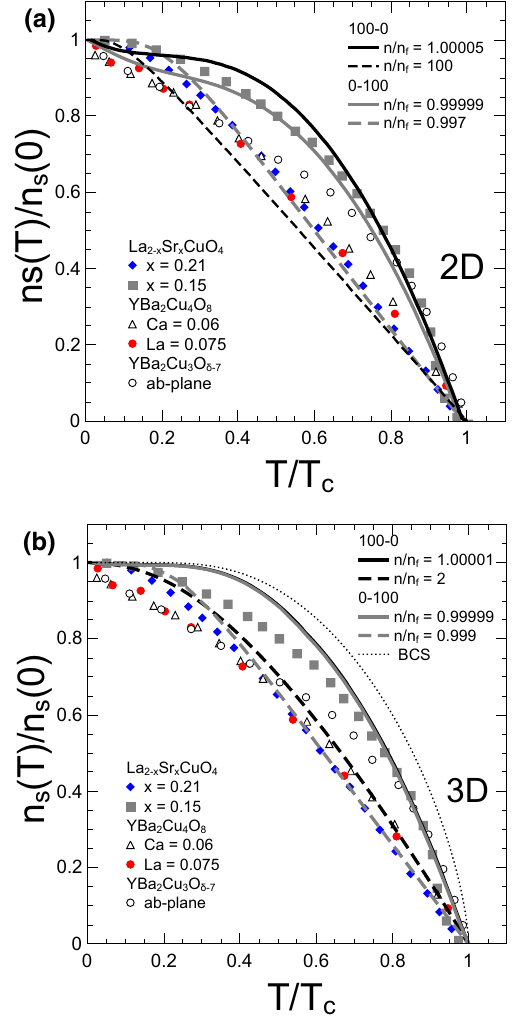
Fig. 3 (Color online) a 2D superfluid density n s ( T )∕ n s ( 0 ) vs T ∕ T c from the extended crossover for 100%–0% case using (17) black- full curve with n ∕ n f = 1.00005 near weak coupling and the black-dashed curve with n ∕ n f = 100 strong-coupling regime. For 0%–100% case using (18) gray-full curve with n ∕ n f = 0.99999 and gray-dashed curve with n ∕ n f = 0.997 each compared with HTSC data of YBa 3 CuO 𝛿 − 7 ab-plane [63] (open circles); La 2 − x Sr x CuO 4 [64] (gray squares) x = 0.15 (blue-online diamonds) x = 0.21 ; YBa 2 Cu 4 O 8 [65], Ca = 0.06 (open triangles) and La = 0.075 (red online circles). There is two important cuprate-SC results shown here between the 100%–0% and 0%–100% cases near the weak cou- pling regime and between the 100%–0% strong-coupling regime and 0%–100% gray-dashed case suggesting that these SCs might be correctly described by bosonic 2hCPs in 2D. b 3D superfluid density n s ( T )∕ n s ( 0 ) vs. T ∕ T c from the extended-crossover theory for 100%–0% case using (17) black-full curve with n ∕ n f = 1.00001 near weak coupling and the black-dashed curve with n ∕ n f = 2 interme- diate coupling. For the 0%–100% case using (18) gray-full curve with n ∕ n f = 0.99999 and gray-dashed curve with n ∕ n f = 0.999 each compared with HTSC data and BCS (dotted-gray) curve is included for comparison purposes only. Finally, near weak-coupling regime the 3D case is far from data